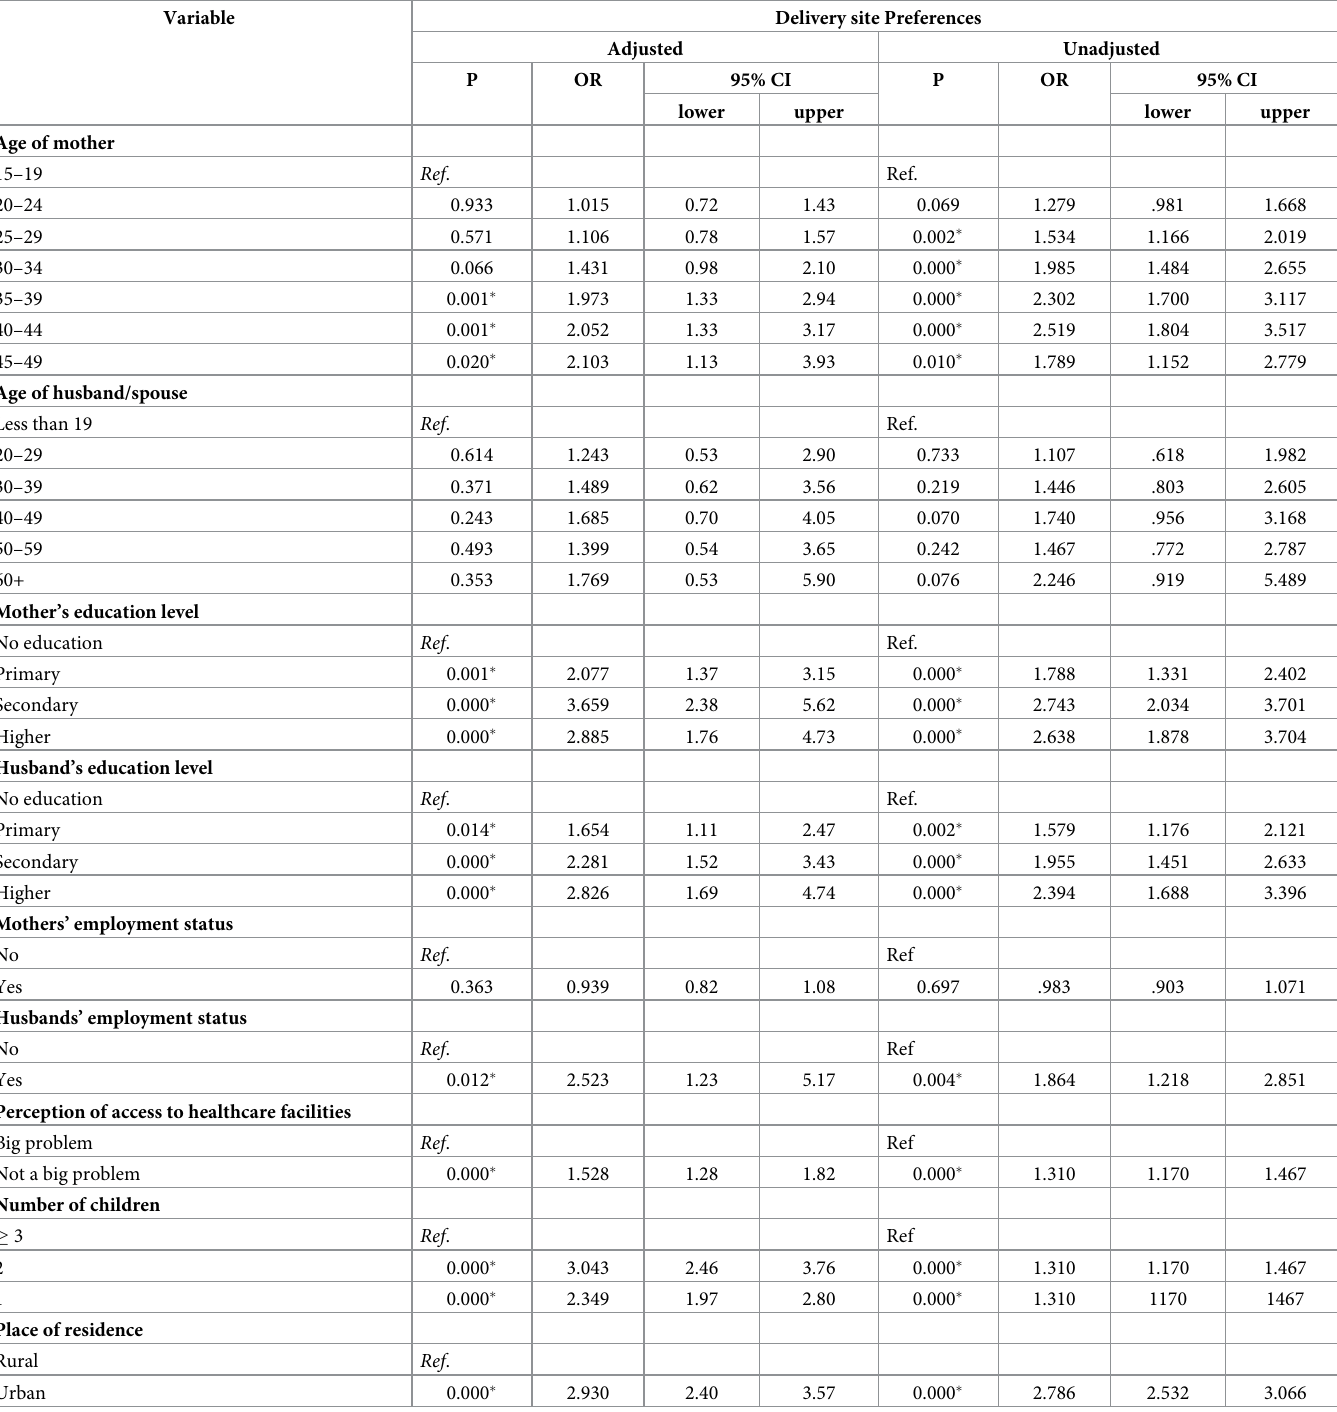
Table 2. Binary logistic regression of determinants affecting birthplace